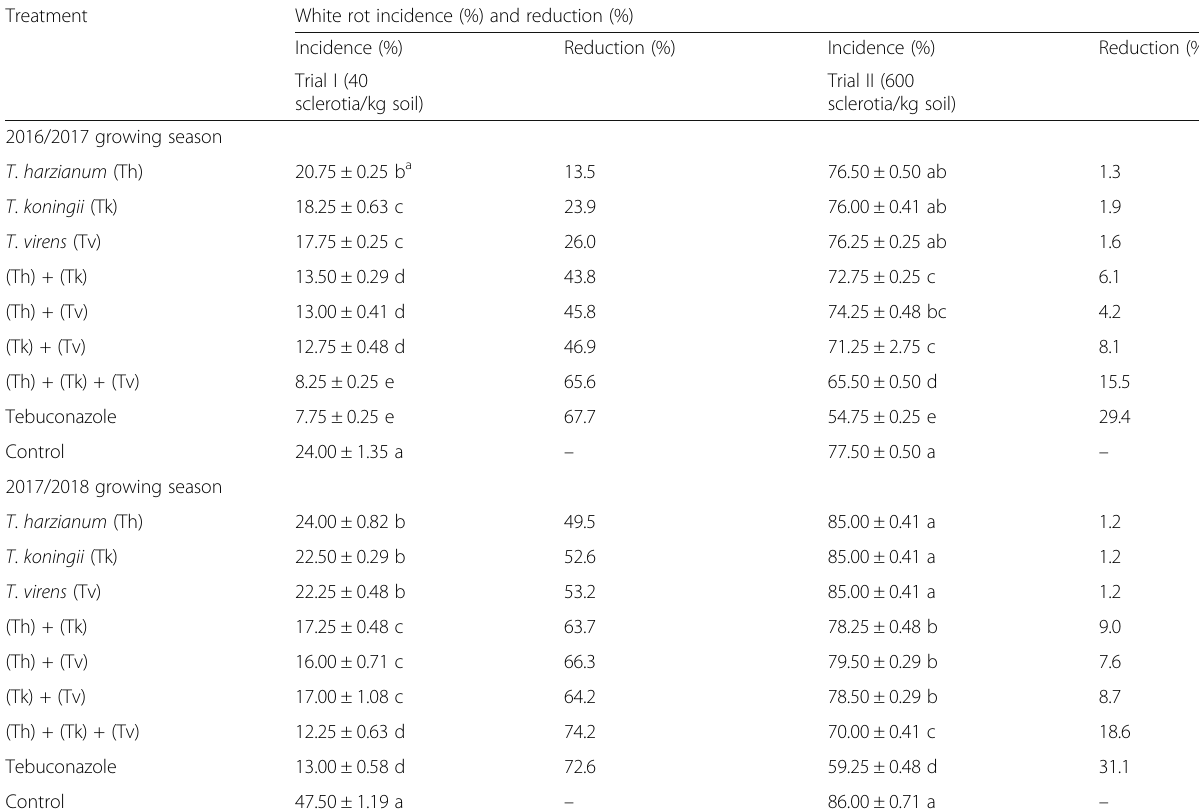
biomass) were 27.1, 33.0, and 42.1%, respectively compared with the control (Table 6). The effects on garlic grown in soil with high inoculum density followed the same trend (Table 6). The effects of soil application with Trichoderma isolates and their combinations on garlic bulb yield at two